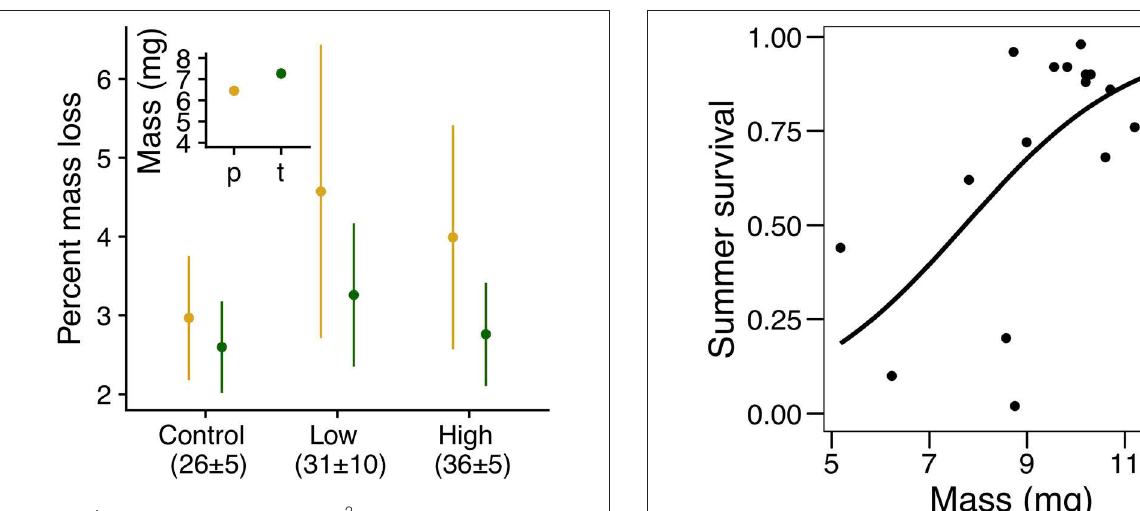
FIGURE 6 | Mass (inset, LS means ± SE , χ 2 = 6.44, P = 0.01) and percent mass lost (interaction: χ 2 = 8.69, P = 0.013, host: χ 2 = 0.46, P = 0.5, regime: χ 2 = 111.23, P < 0.0001) by dormant E. phaeton larvae during exposure to summer heatwaves. Larvae had previously fed on C. glabra (c, green) or P. lanceolata (p, yellow).